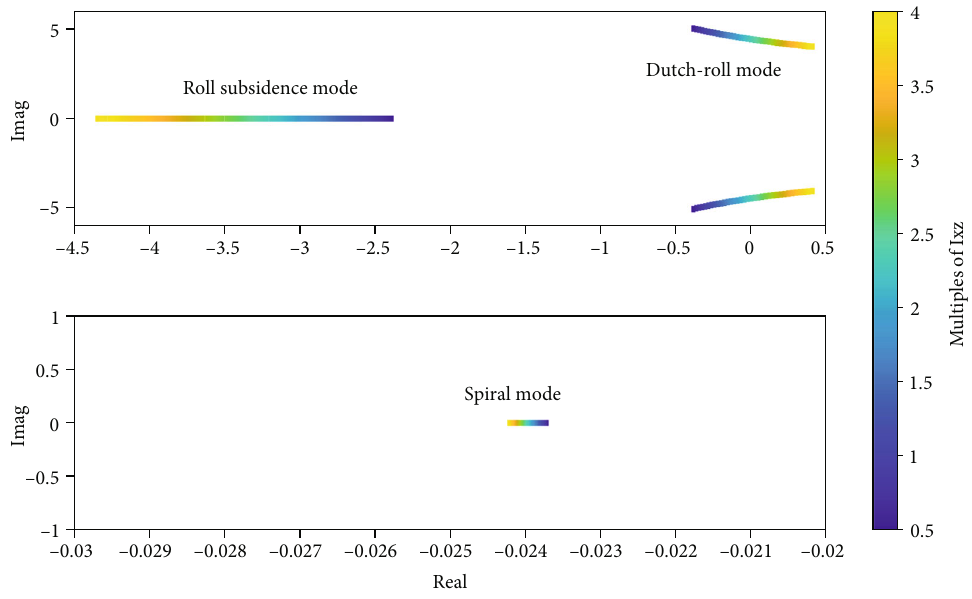
Figure 4: Lateral – directional modes change with multiples of I